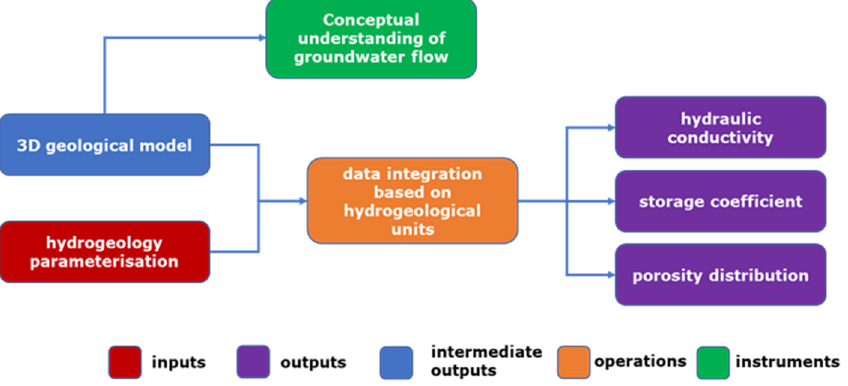
Figure 9. Hydrogeological processing framework.